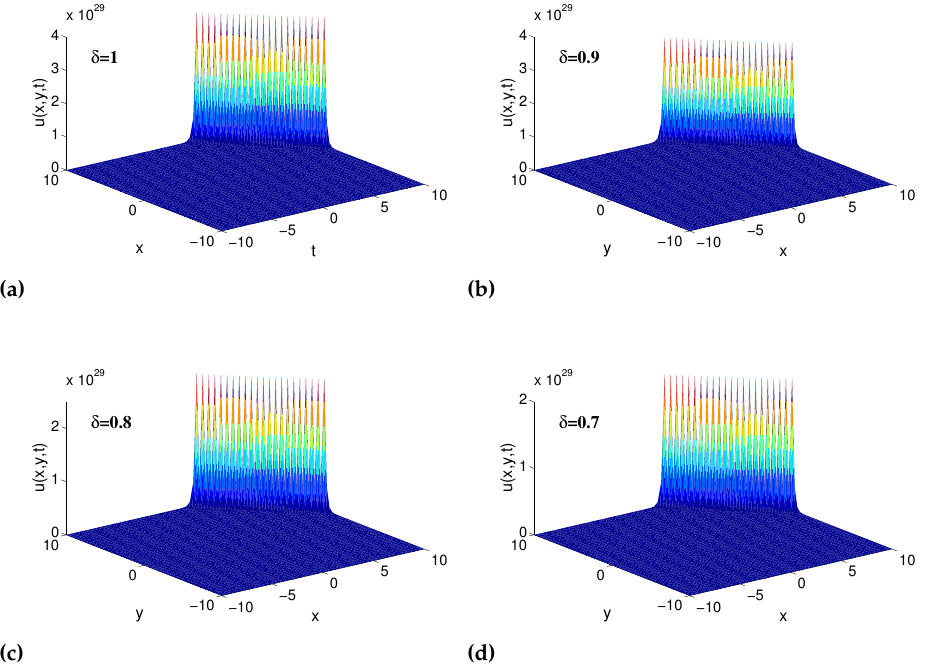
Figure 4. The numerical simulations of Equation (12) with ( a ) δ = 1, r = 50 ( b ) δ = 0.9, r = 50 ( c ) δ = 0.8, r = 50 ( d ) δ = 0.7, r = 50 and t =